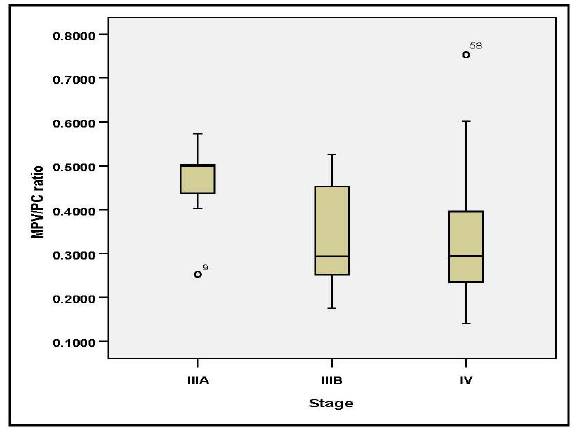
Figure 1: The average MPV/PC ratio according to the stage in patients with advanced NSCLC ( p =0.015).